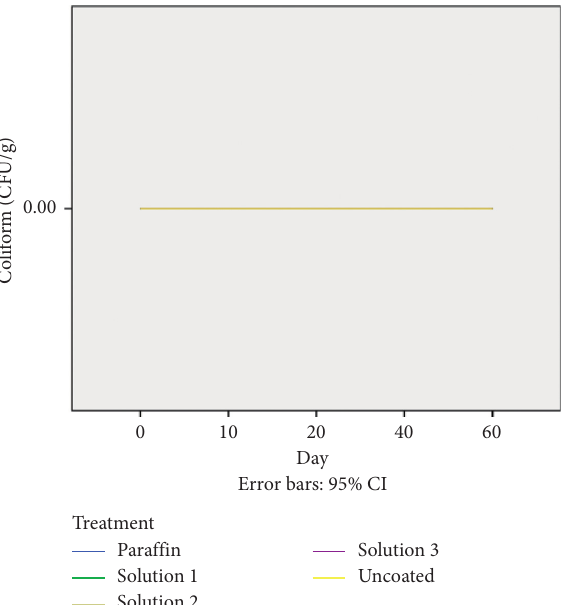
Figure 14: Coliform count (means ± SD) of cheese coated with antimicrobial edible coatings compared with cheese coated with commercial coating and uncoated cheese throughout 60d of storage at 10 ° C and 85% relative humidity.